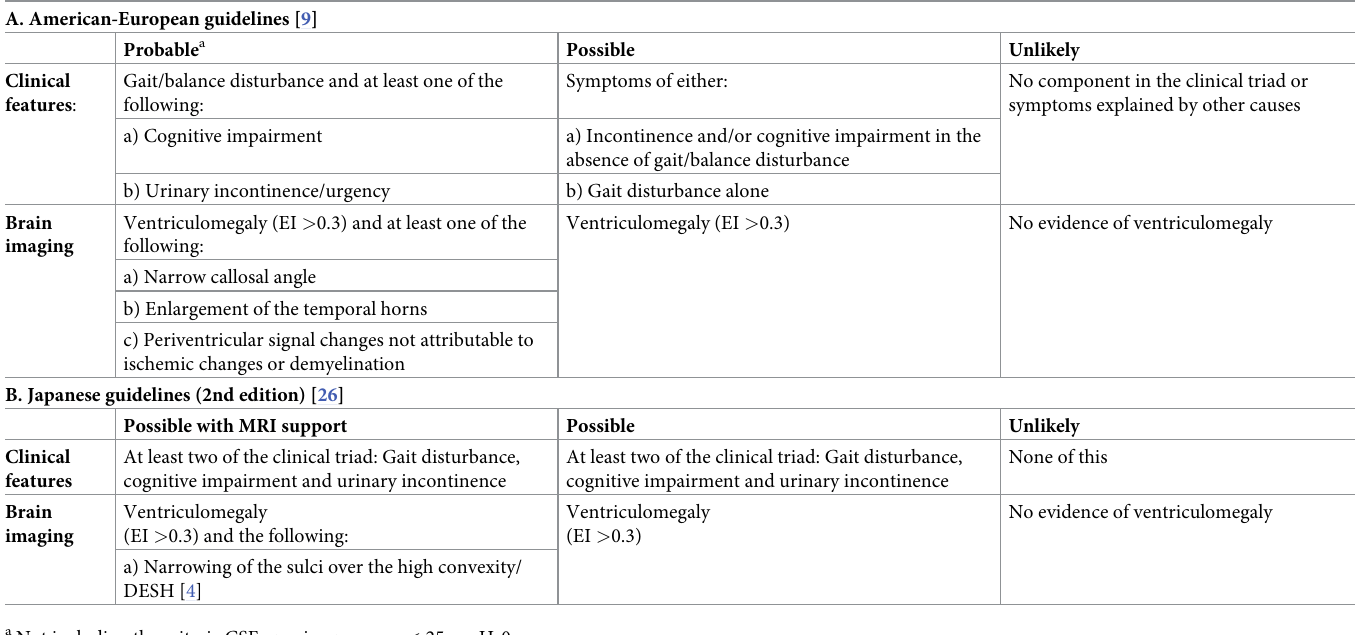
Table 1. Diagnostic criteria according to the two international